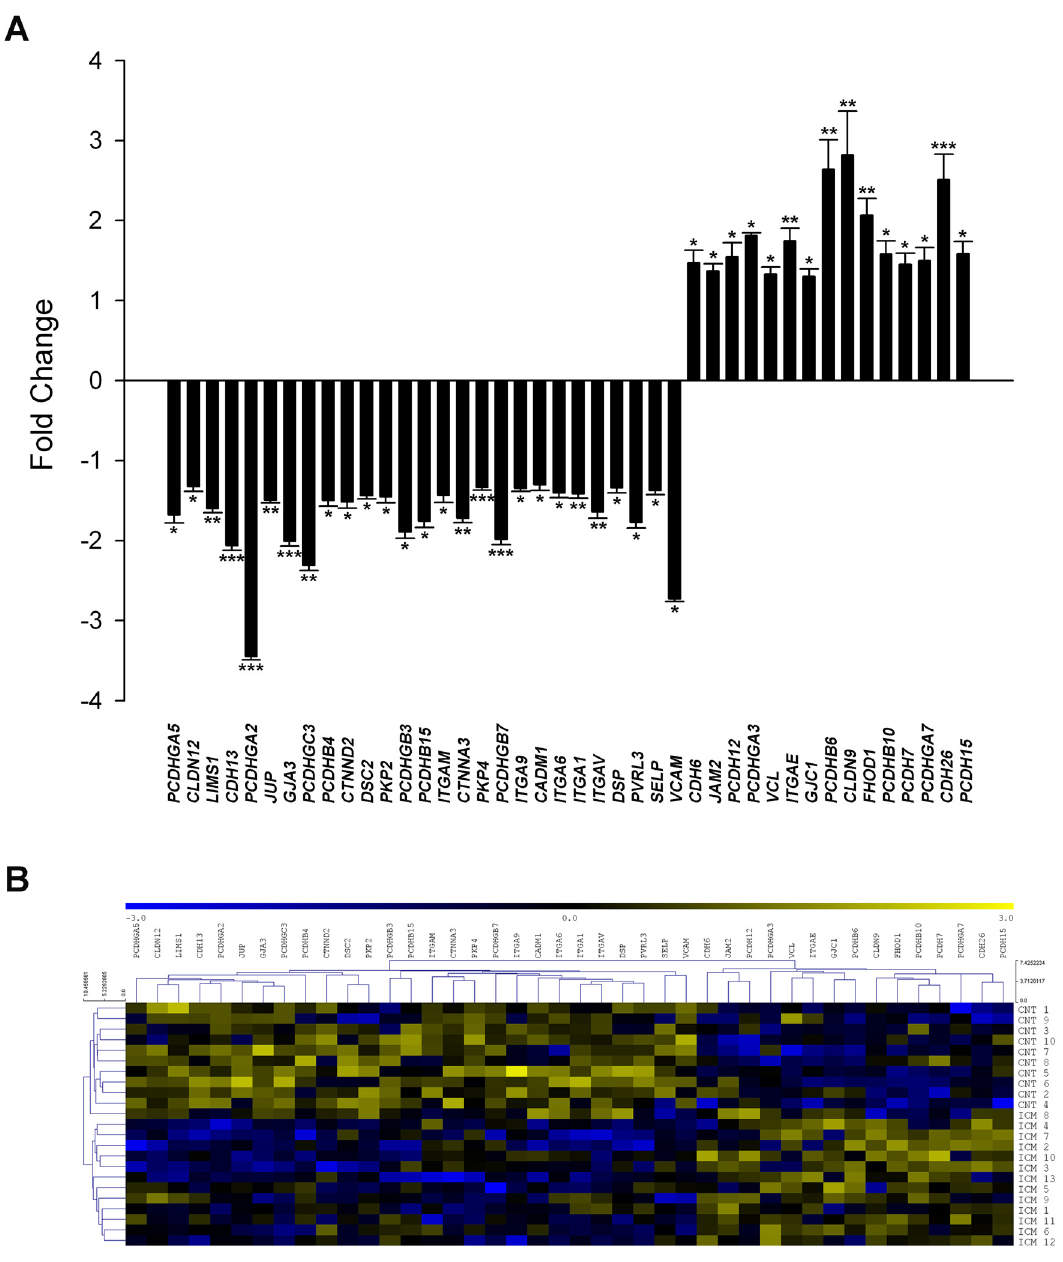
Fig 2. Differential gene expression profiles of cell adhesion molecules in ICM patients displaying 42 altered genes. (A) . RNA-sequencing results showing mRNA expression levels of cell adhesion genes. The values of the CNT group are set to 1. The data are expressed as mean ± SEM for the relative mRNA expression levels. (B) . Heat map with hierarchical clustering of the transcriptomic analysis. Columns: genes; rows: samples. The relative expression level of each gene is indicated by the colour bar: blue, lowest; yellow, highest. ICM, ischemic cardiomyopathy; CNT, control. * P < 0.05, ** P < 0.01, *** P < 0.001 vs CNT group.